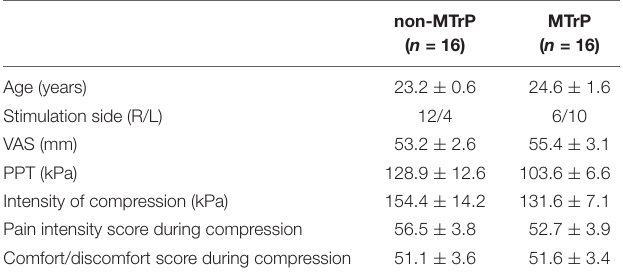
TABLE 2 | Baseline characteristics and stimulus conditions in the two groups.